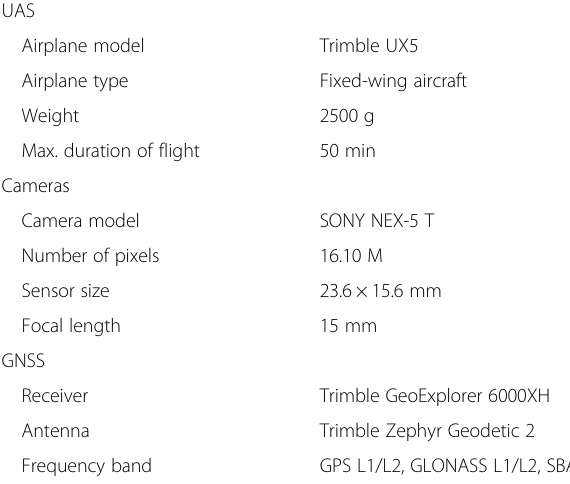
Table 1 General information related to the unmanned aerial system (UAS), camera, and global navigation satellite system